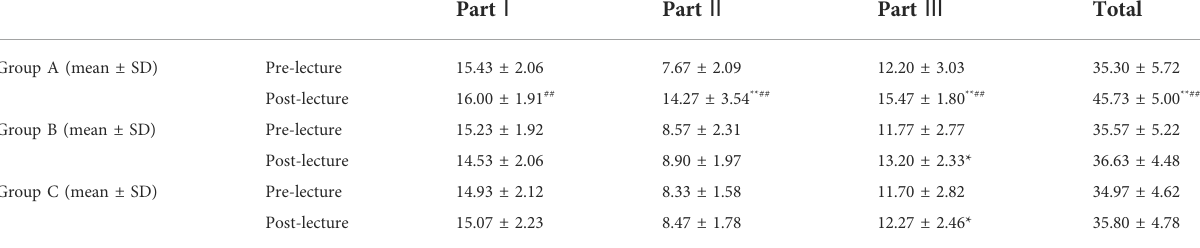
TABLE 5 Improvement of residents ’ performance of three